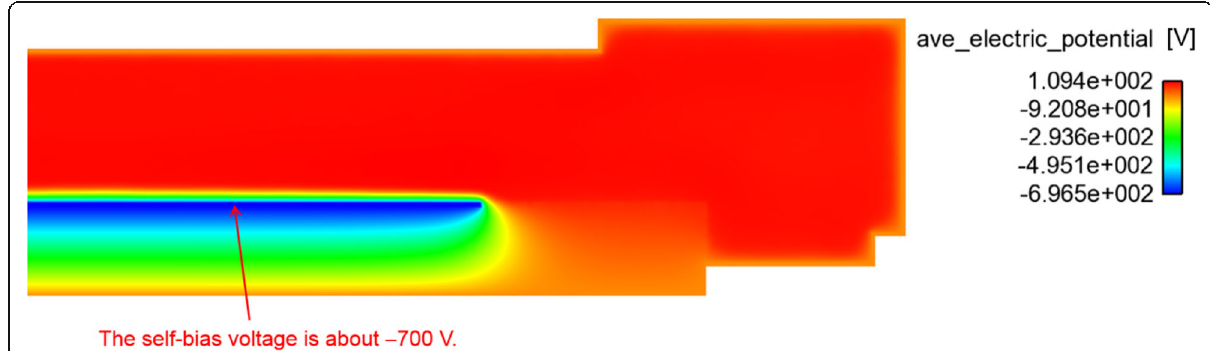
Fig. 7 Simulation of electric potential distribution for plasma etching in the